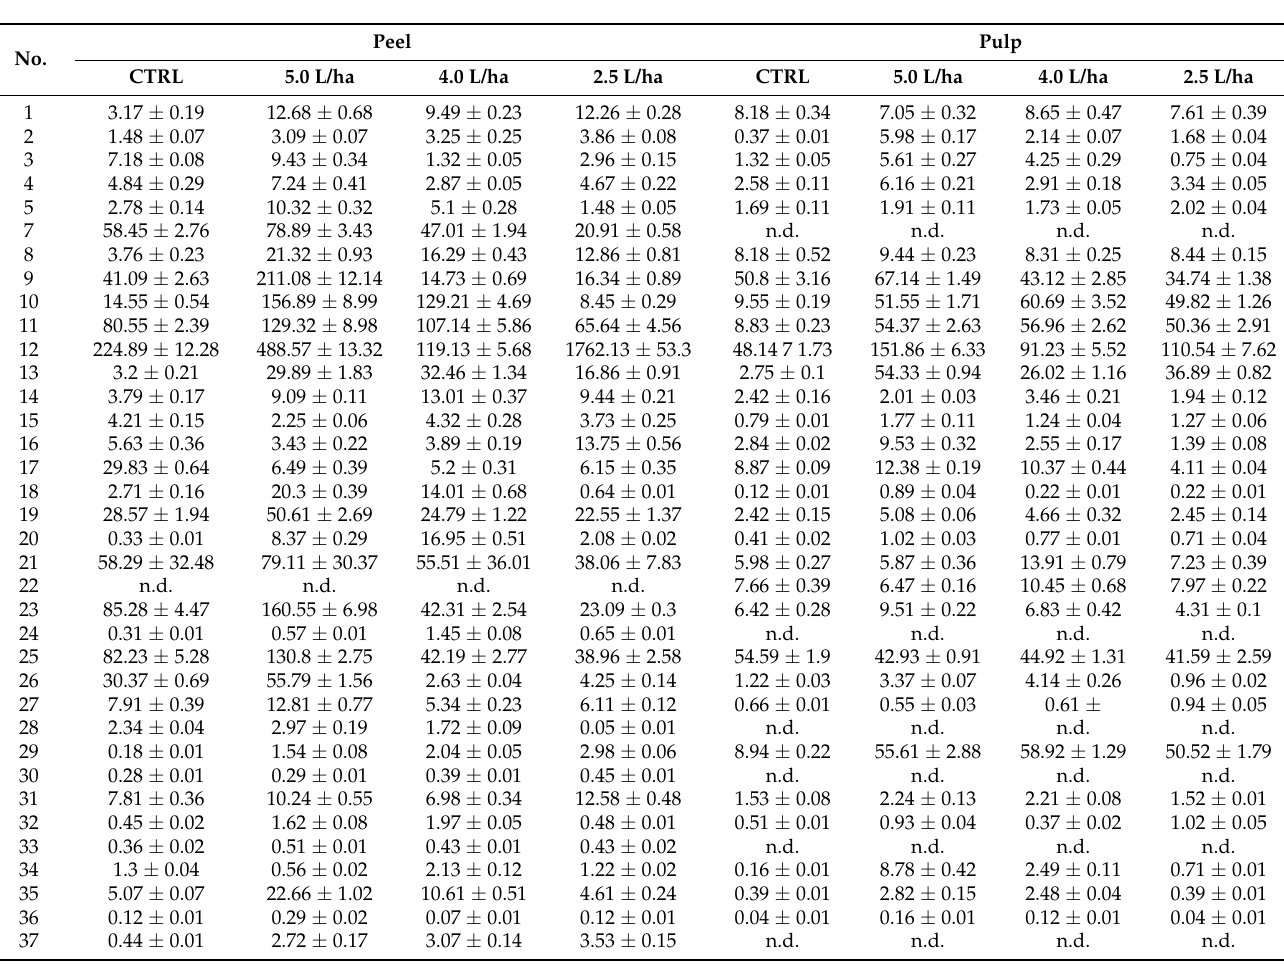
Table 2. Quantitative analysis of polyphenols identified in the fruit peel and pulp of the “Sugar Time” variety harvested from Prunus persica trees after treatment with three different concentrations of biostimulant (5.0, 4.0 or 2.5 L/ha) or with water alone. In the different panels, CTRL identifies samples harvested from trees treated with water only. Quantification is expressed as the mean ± SD of three experiments conducted in triplicate, and the values are expressed as mg per 100 g fresh weight (FW). The first column reports the identification number of each compound as listed in Table 1 and shown in Figure